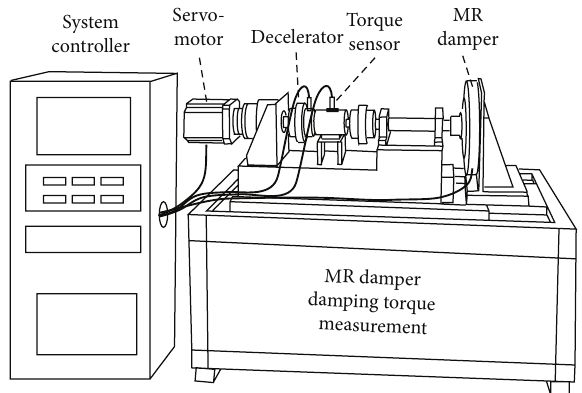
Figure 13: Apparatus for performing damping torque measurement tests.